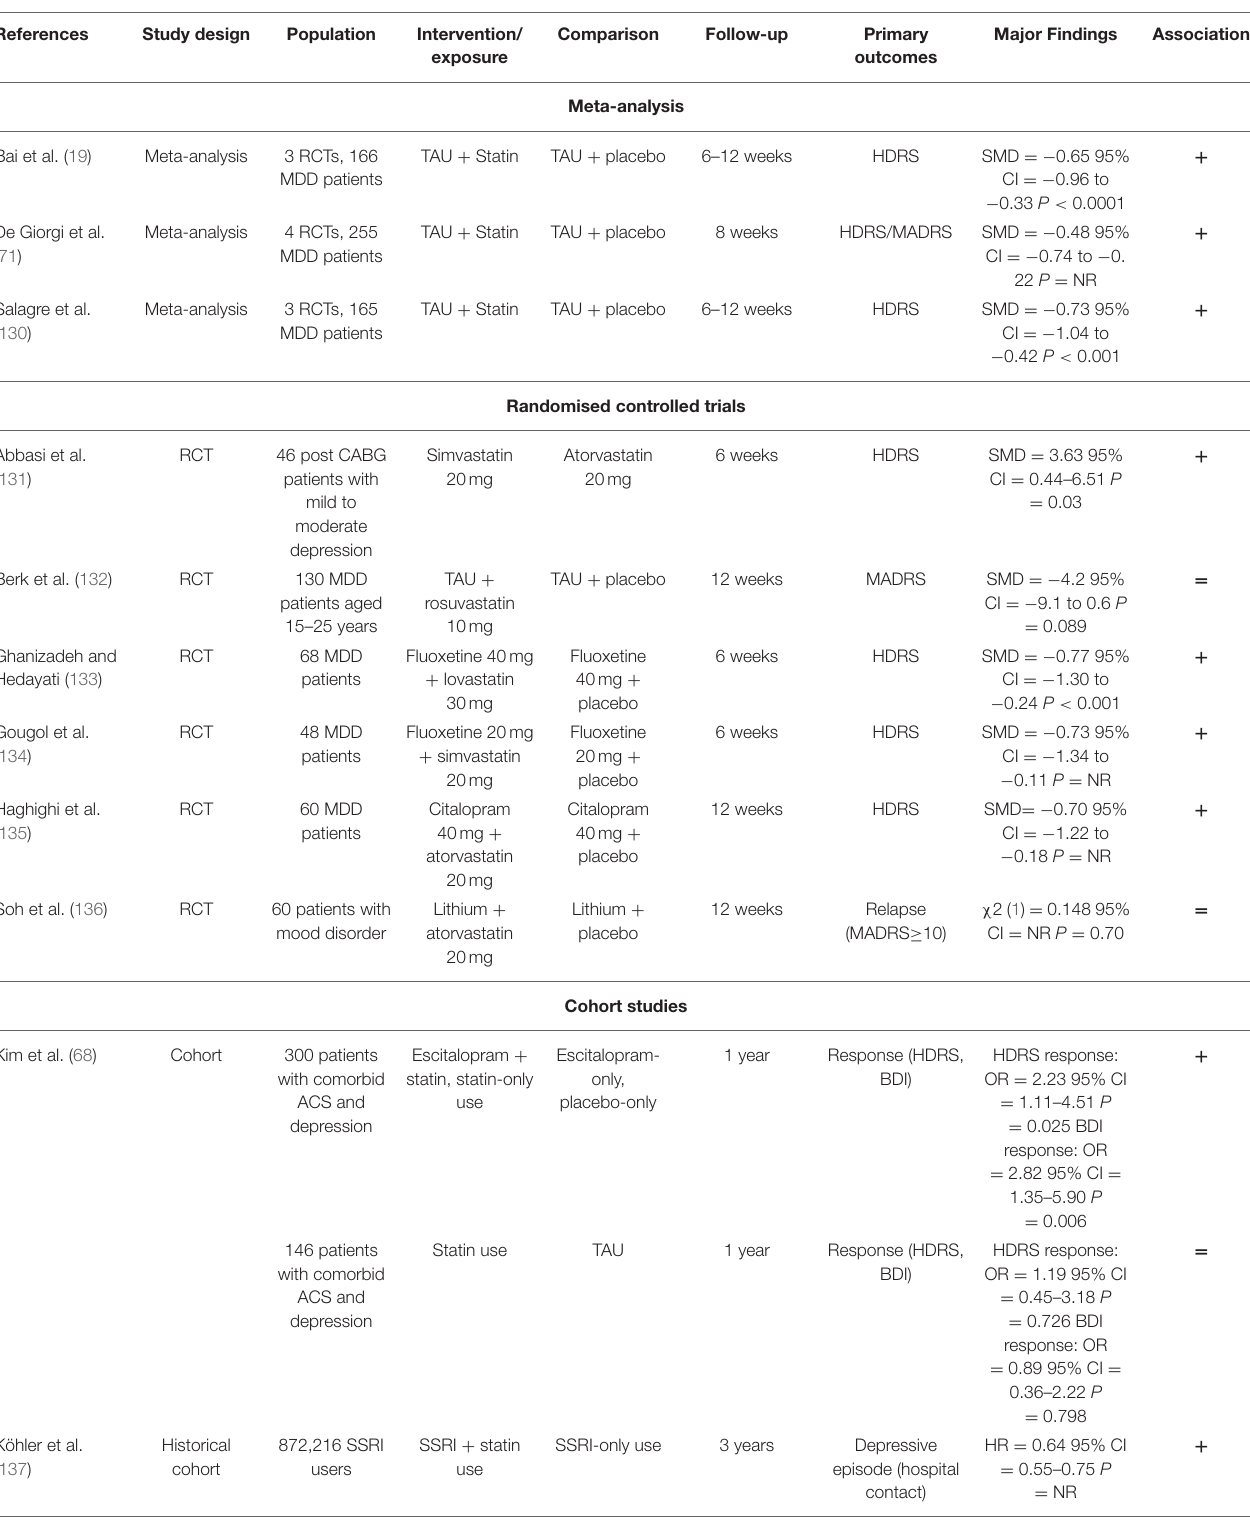
TABLE 3 | Overview of studies regarding the effects of statins on the risk of developing depressive episodes or on depressive symptoms scores in depressed